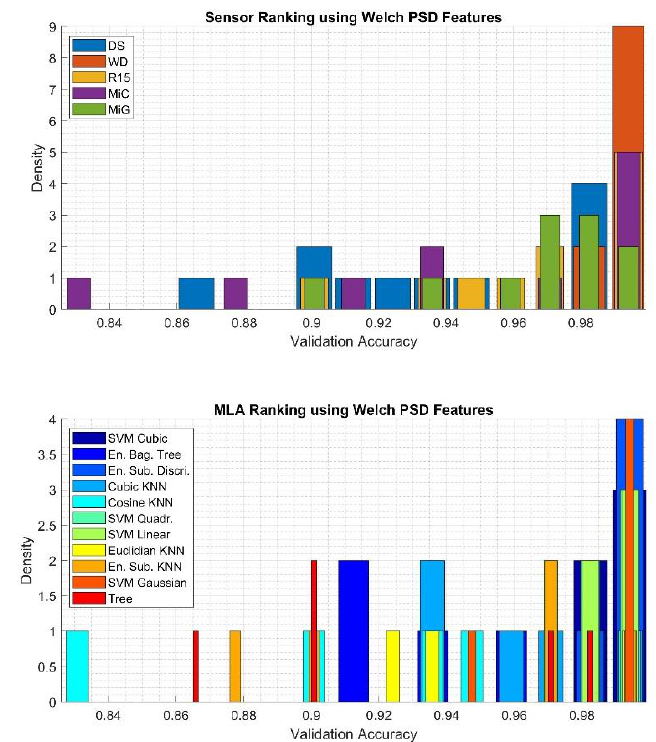
Figure 11. Results of analysis depicting quantities of the best sensor (upper) and the best MLA (bottom) applied for classification using the Welch PSD features determined using validation accuracy value.